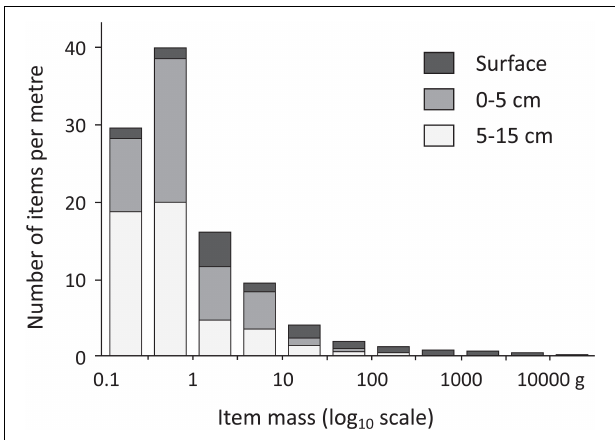
FIGURE 2 | The frequency distribution of the masses of macro-litter items recorded at three depth strata in the beach in the West Coast National Park, South Africa in 2010 (surface litter data from four 50-m cleaned areas, buried data from eight paired 1-m wide sieved transects; items < 0.1 g pooled into the smallest size class).